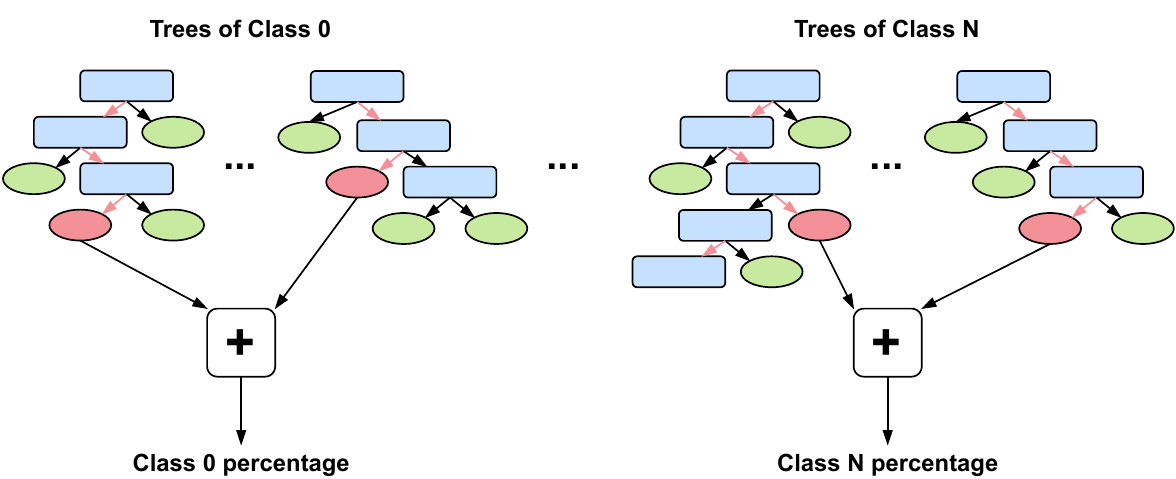
Figure 2. Gradient Boosting Decision Trees (GBDT) results accumulation with one-vs-all